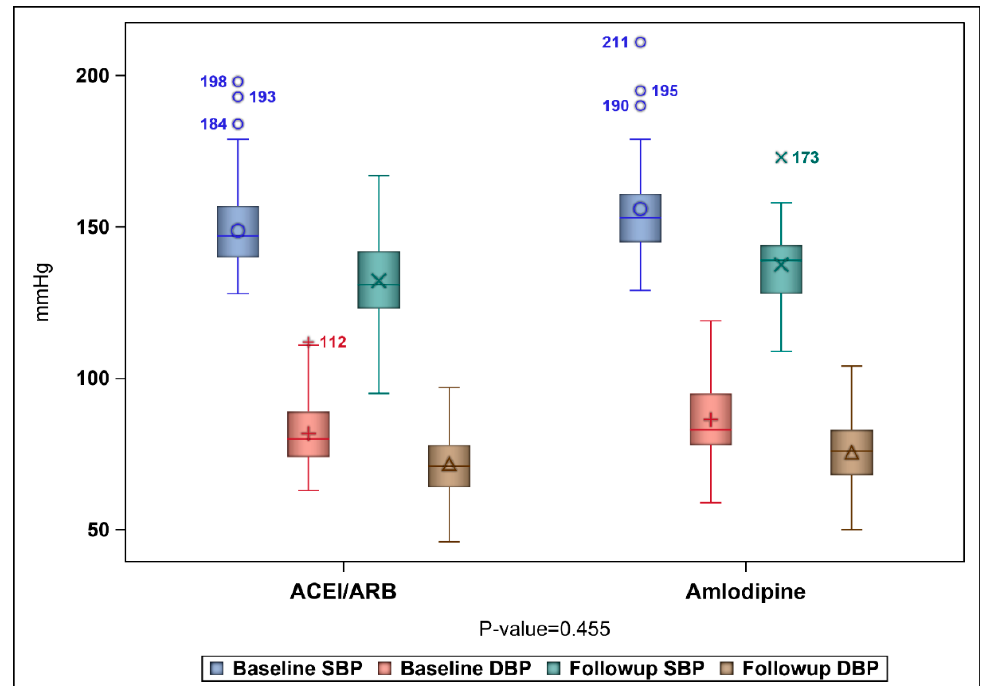
Figure 2. Box plot of baseline and follow-up SBP and DBP for patients on ACEIs/ARBs and amlodi- pine. The box represents the 25th and 75th percentiles, and the whiskers are the upper and lower , , , represent the means of the baseline SBP, baseline DBP, follow-up SBP, and follow-up DBP, respectively. The outside written values are outliers.